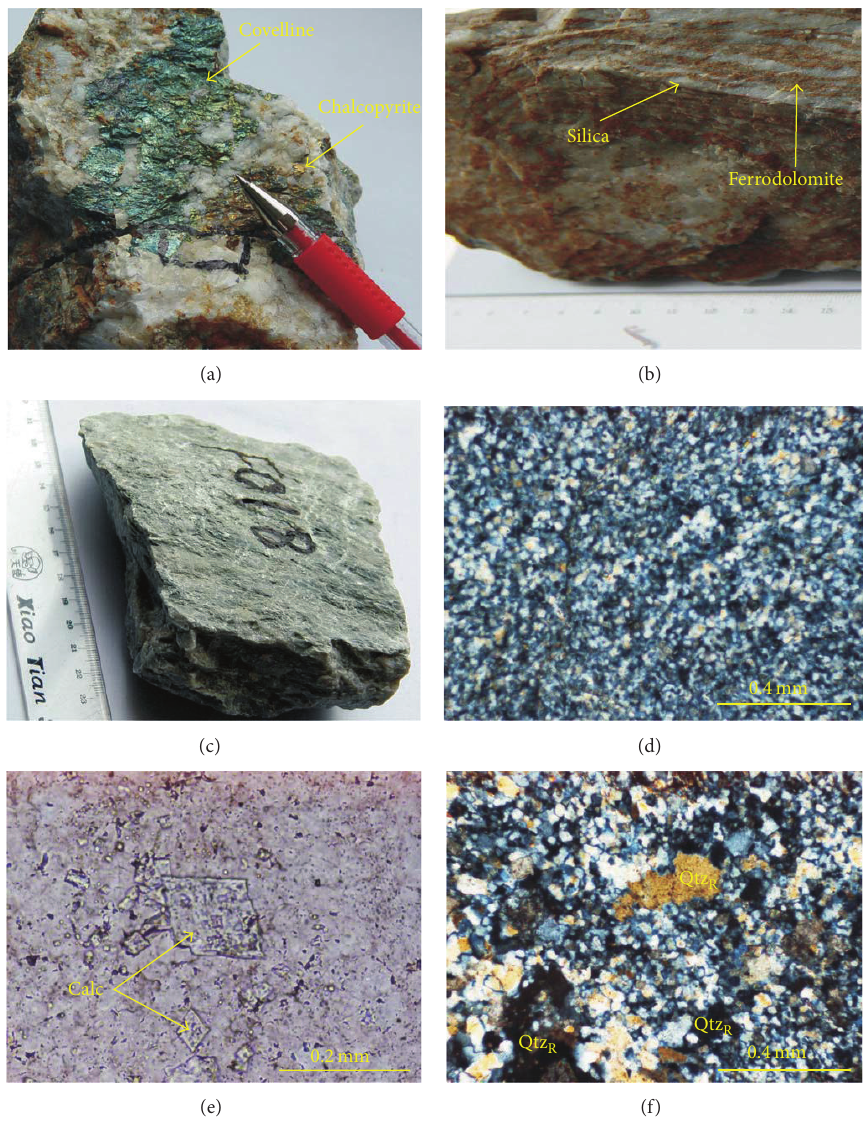
Figure 5: Ores and siliceous rocks from the Bafangshan-Erlihe ore deposit ((a) copper ore; (b) ferrodolomite-bearing siliceous rocks with lamellar structures, the lamellae of the ferrodolomite were oxidised; (c) pure siliceous rock; (d) finely crystalline siliceous rock under parallel nicols; (e) idiomorphic calcite in parallel nicols; (f) recrystallized quartz in crossed nicols; Calc-Calcite, Qtz R -recrystallized